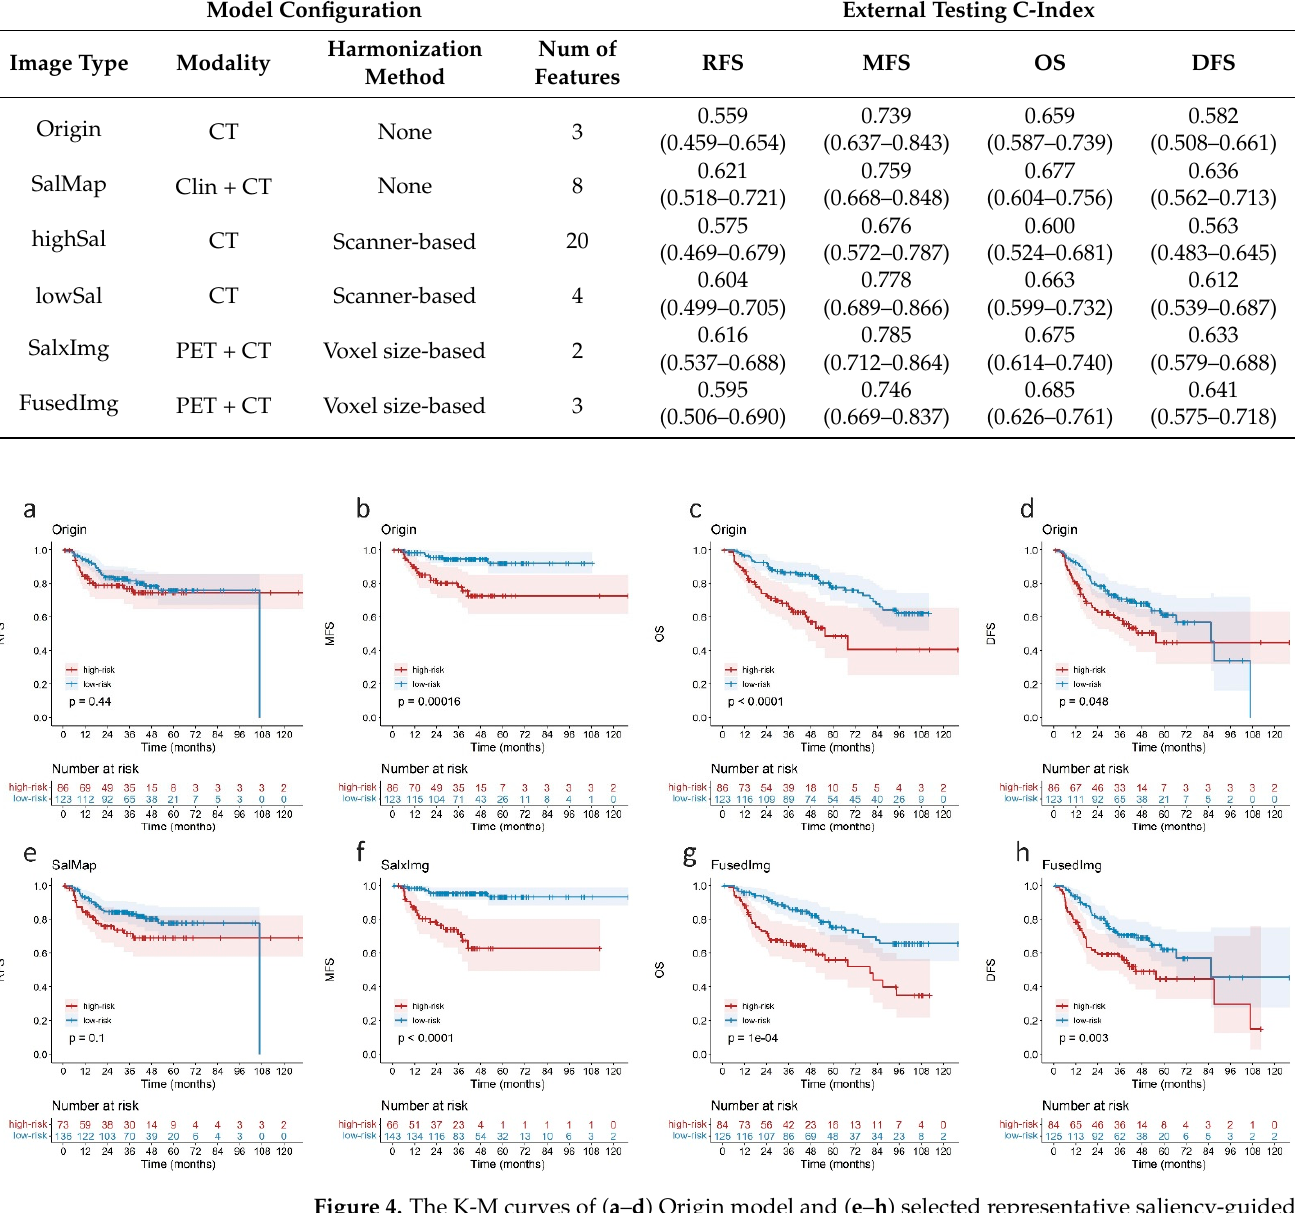
Figure 4. The K-M curves of ( a – d ) Origin model and ( e – h ) selected representative saliency-guided models from Table 2 in external testing cohort (209